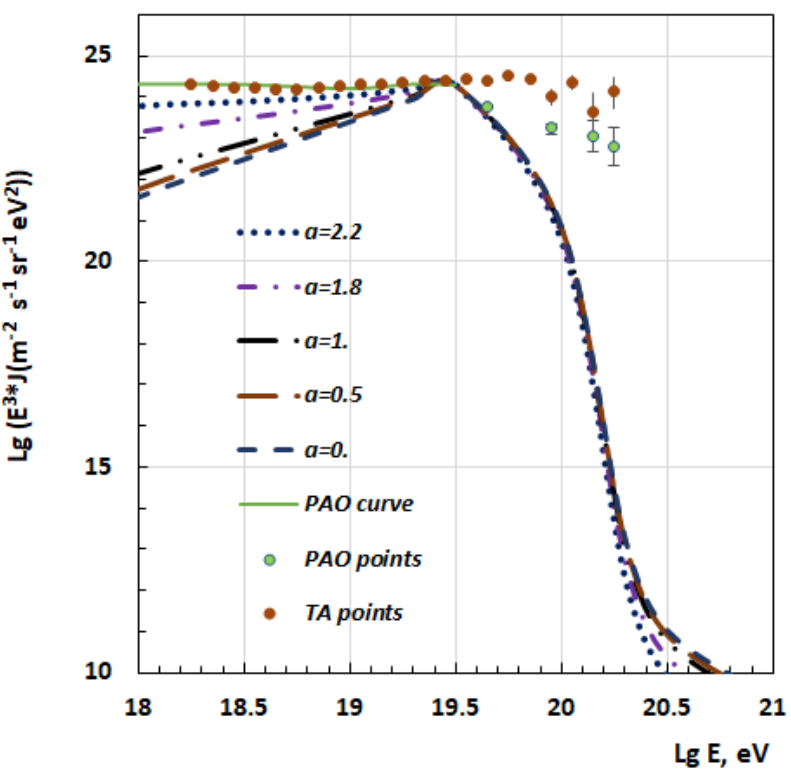
Figure 1. Model of UHE CR spectra on Earth calculated for injection spectra with various spectral indices a (see the legend), along with the spectra measured on the PAO [24] and the TA [26]. Model spectra are normalized to the PAO data [24] at the energy of 10 19.5 eV.